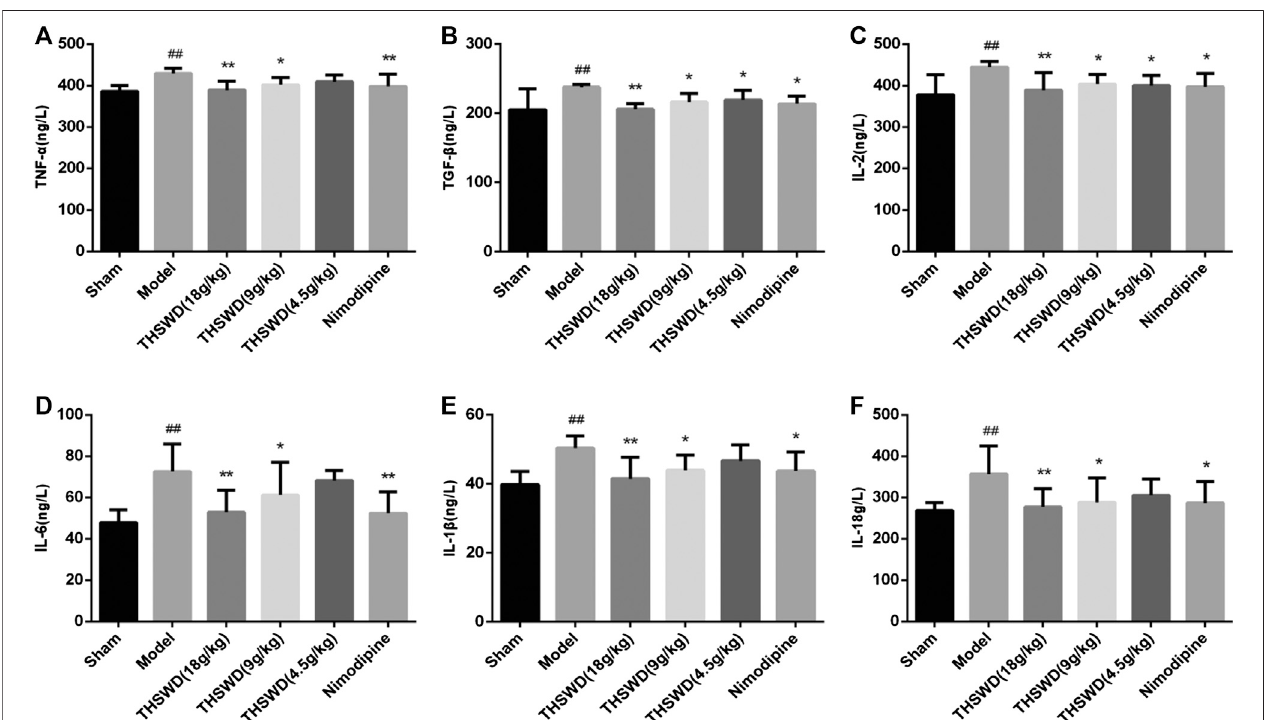
FIGURE 3 | Taohong Siwu decoction (THSWD) reduced the levels of in fl ammatory factors in middle cerebral artery occlusion-reperfusion (MCAO/R) rats. (A) TNF- α , (B) TGF- β , (C) IL-2, (D) IL-6, (E) IL-1 β , (F) IL-18. The results were presented asthe mean ± SD ( n (cid:2) 6). Compared withsham group, # p < 0.05, ## p < 0.01. Compared with model group, * p < 0.05, ** p <